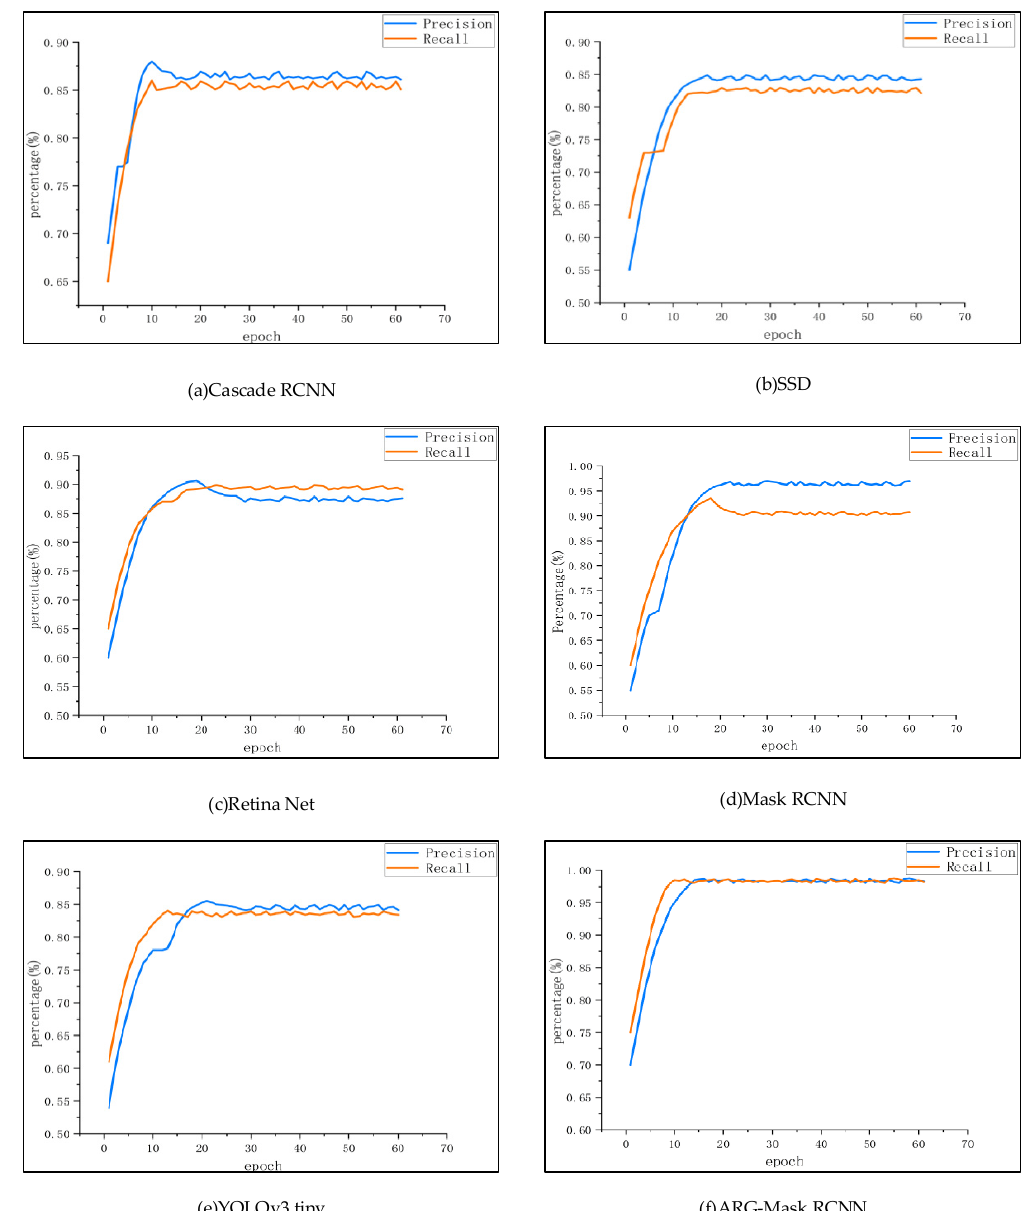
Figure 12. Precision and Recall variation curves for six different methods.